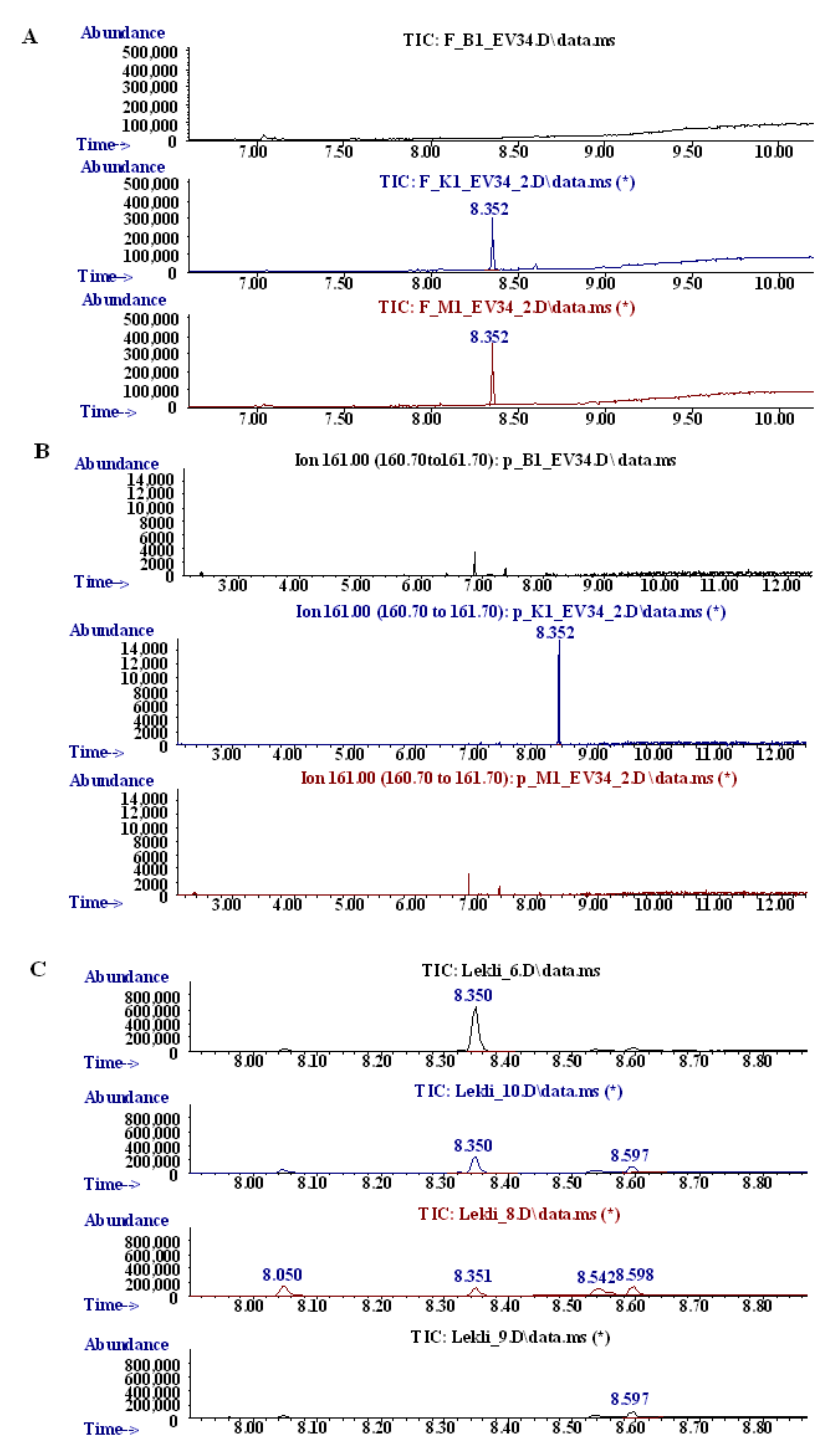
Figure 2. Stability of EV-34: ( A ) Oxidation by the chemical Fenton system. Reaction mixtures for blank contained 1% DMSO only without EV-34. The control tube contained all reagents and EV-34 except hydrogen peroxide, which is responsible for the initiation of the reaction. The sample tube contained all reagents; EV-34 concentration was 2.5 mM. ( B ) Mimic oxidation by synthetic porphyrin. The sample tube contained all reagents; EV-34 concentration was 10 mM. ( C ) To mimic biological environment stability of EV-34 was studied in rat blood and liver lysates. EV-34 concentration was 20 µM in the samples.